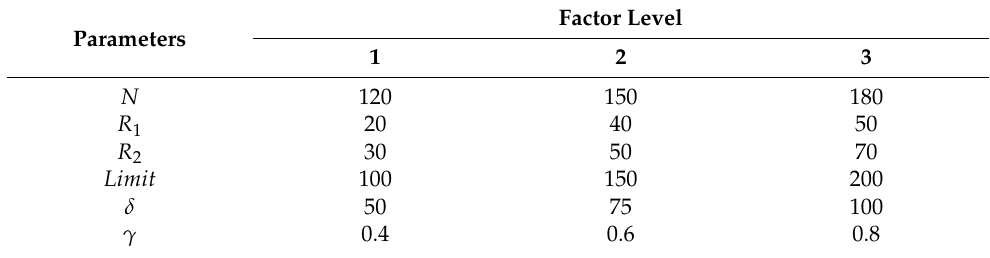
Table 5. Levels of the